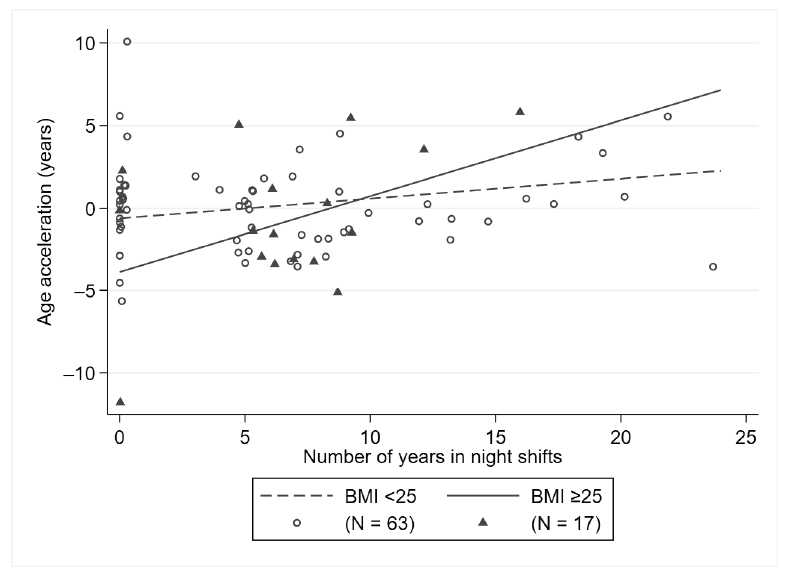
Figure 1. Association between the number of years in night shifts and age acceleration, stratified by BMI.